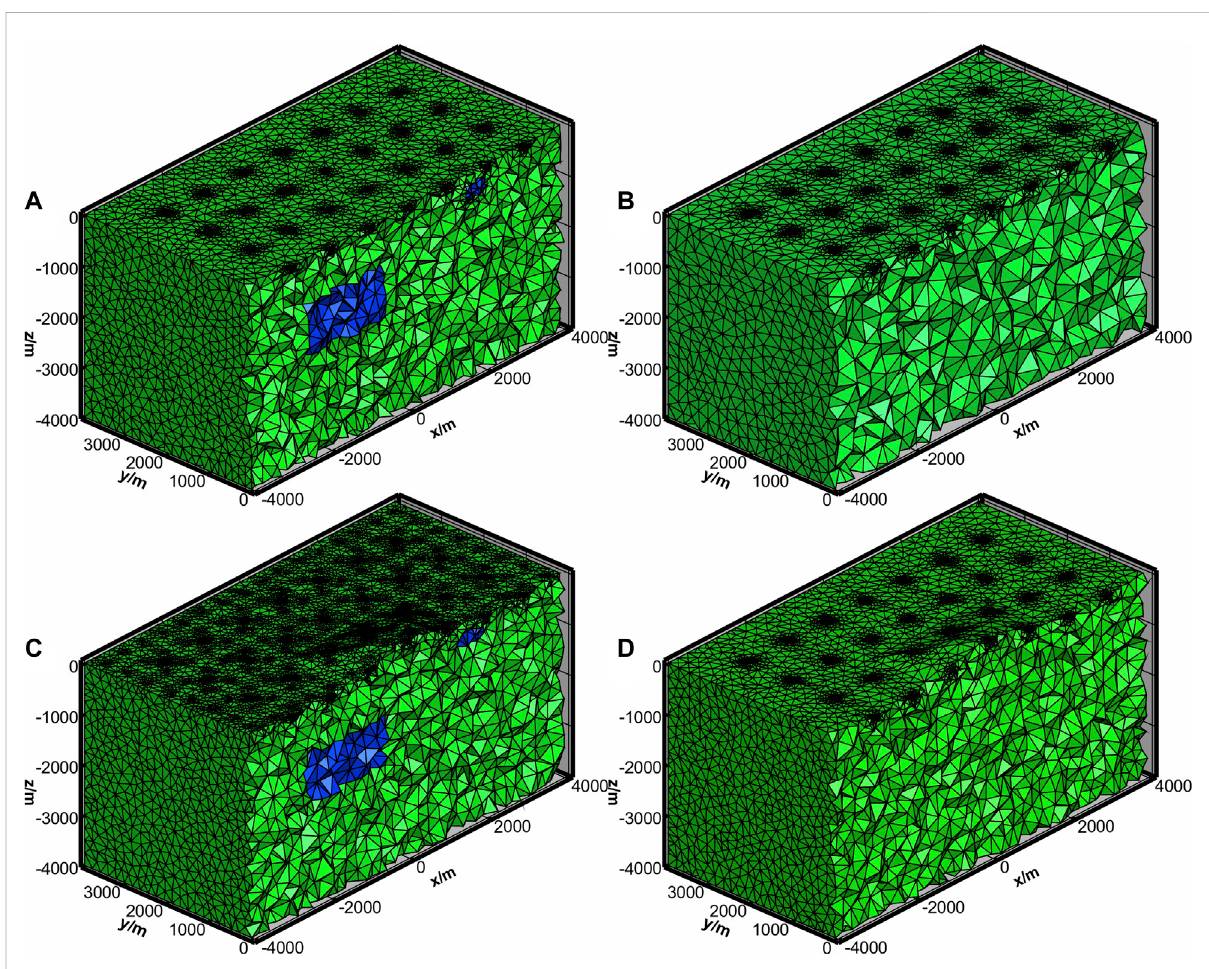
FIGURE 2 Model discretization for (A) forward modeling without topography, (B) inversion without topography, (C) forward modeling with topography, and (D) inversion without topography.